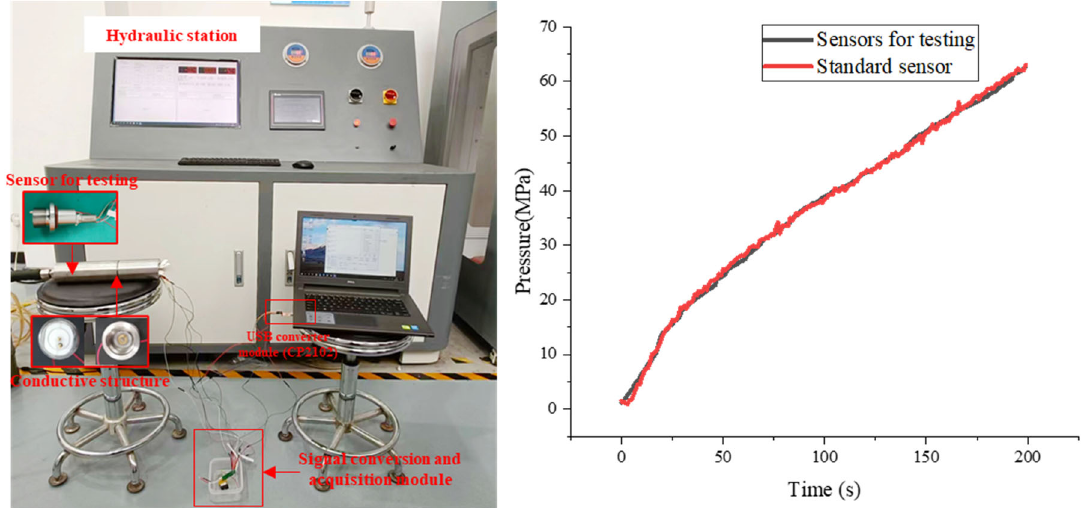
Figure 30. Comparison experiment and results of the pressure sensor